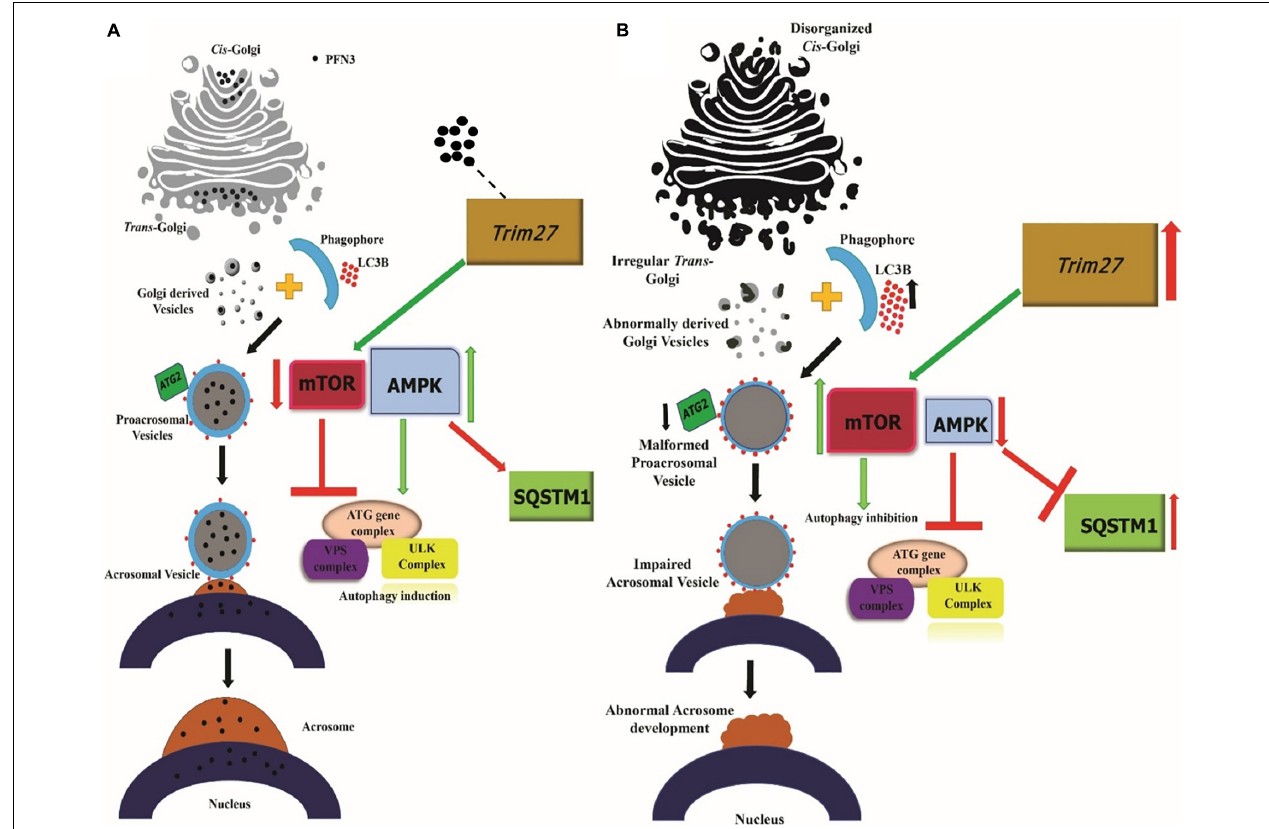
FIGURE 13 | Working hypothesis on the PFN3 role in acrosome biogenesis. (A) Schematic illustration of the Pfn3 presence in Golgi network responsible for proacrosomal formation associated with the autophagy mechanism. (B) Schematic illustration depicting the disrupted autophagy mechanism and acrosome formation in the absence of Pfn3 . Black dots =